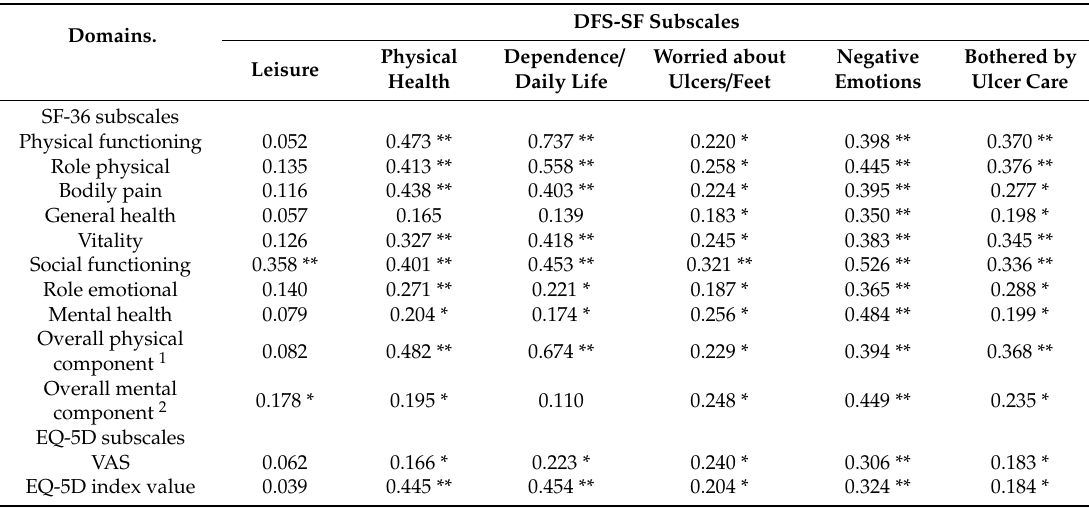
Table 3. Criterion validity of the Diabetic Foot Ulcer Scale-Short Form by Pearson’s correlation coe ffi cients with SF-36 and EQ-5D overall and subscale scores.